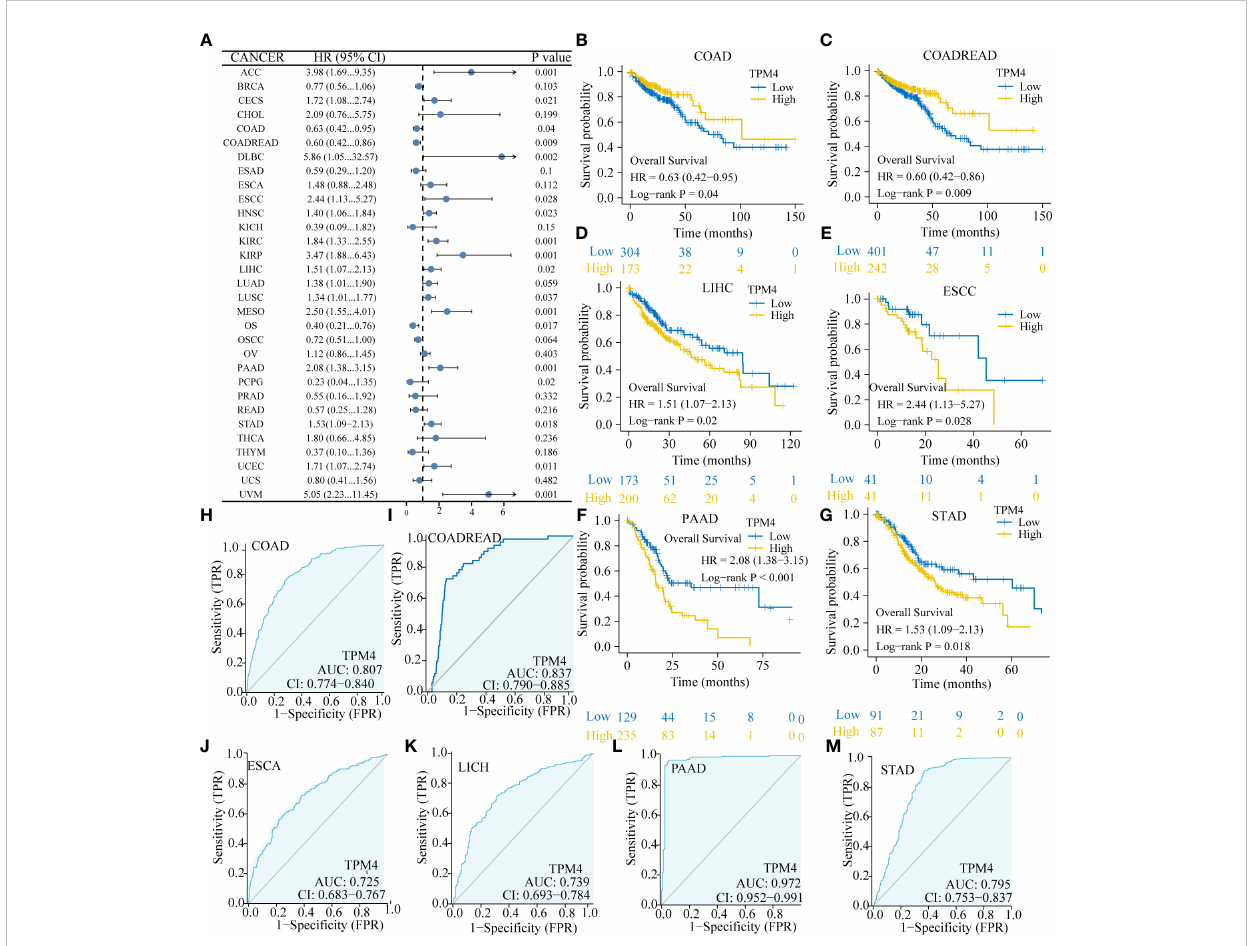
FIGURE 3 Correlation of TPM4 expression and pan-cancer prognosis and diagnosis. (A) Forest plot for the association between pan-cancer TPM4 expression and overall survival (p < 0.05). (B-G) Overall survival analyses for TPM4 expression in digestive system tumors. Patients with COAD ( (B ,n=521), COADREAD (C,n=698), LICH (D, n=424), ESCC (E,n=173), PAAD ((F,n=182), STAD (G,n=407). (H-M) . Diagnostic value of TPM4 in pan-cancer, as determined by ROC curve analysis. COAD ((H,n=521), COADREAD (I, n=698), ESCA ((J, n=173), LCHC (K,n=424) , PAAD ((L,n=182), STAD